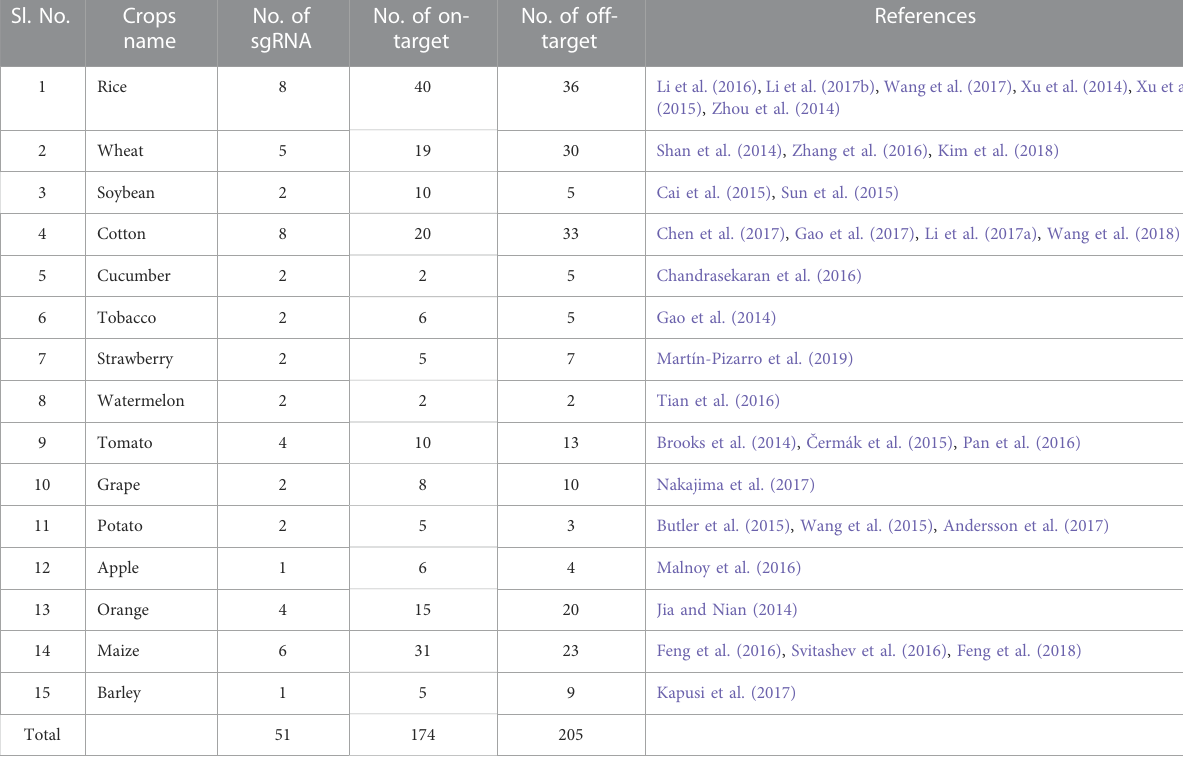
TABLE 2 List of all the features used in this study. Features derived from pair-wise sequence alignment